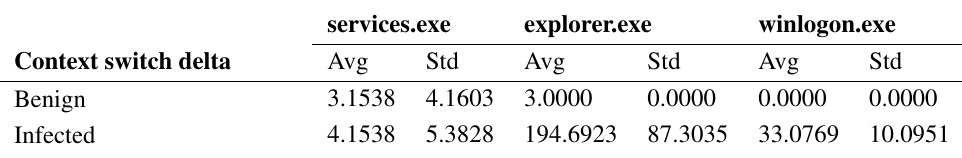
Table 3. Comparing the context switch deltas (per 1 second) of benign and Flame-infected Windows system processes.